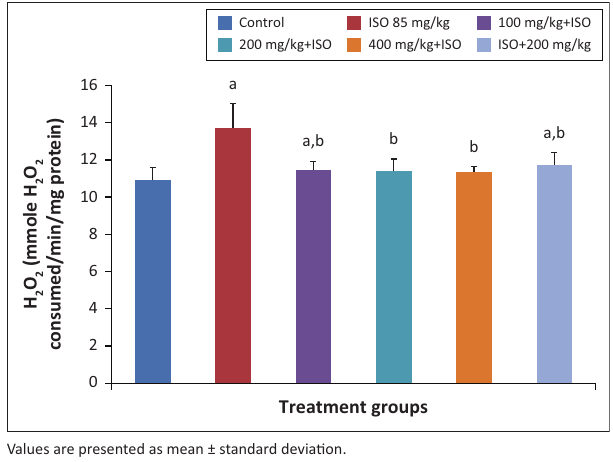
FIGURE 6: Effect of the ethanolic extract of Andrographis paniculata on glutathione-S-transferase enzyme in isoproterenol-induced myocardial infarction using rats as a model ( n = 5).